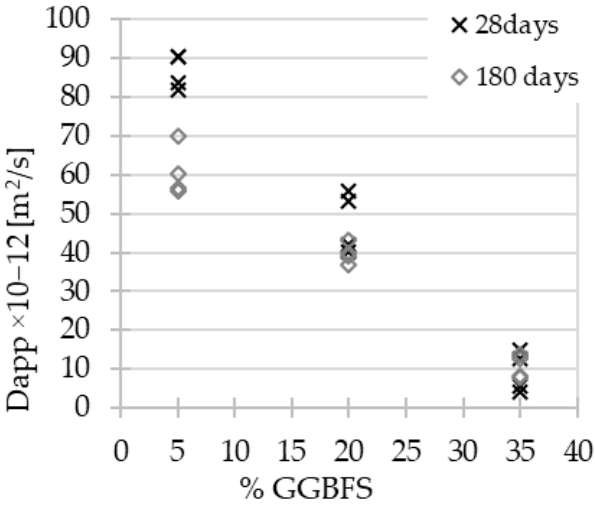
Figure 7. AACs’ chloride diffusion coefficient values vs. GGBFS content.